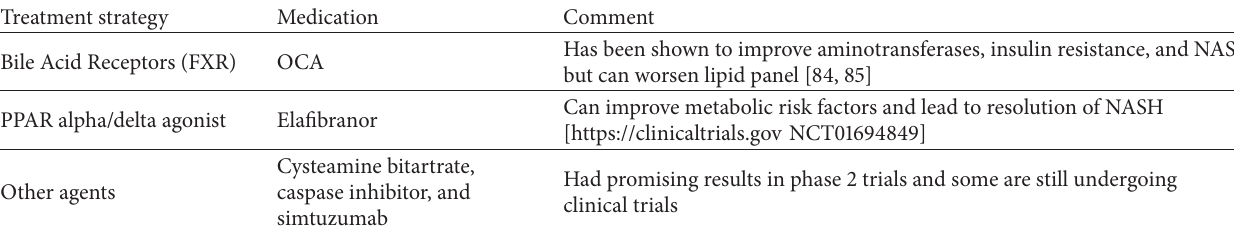
Table 2: Summary of upcoming therapeutic agents for